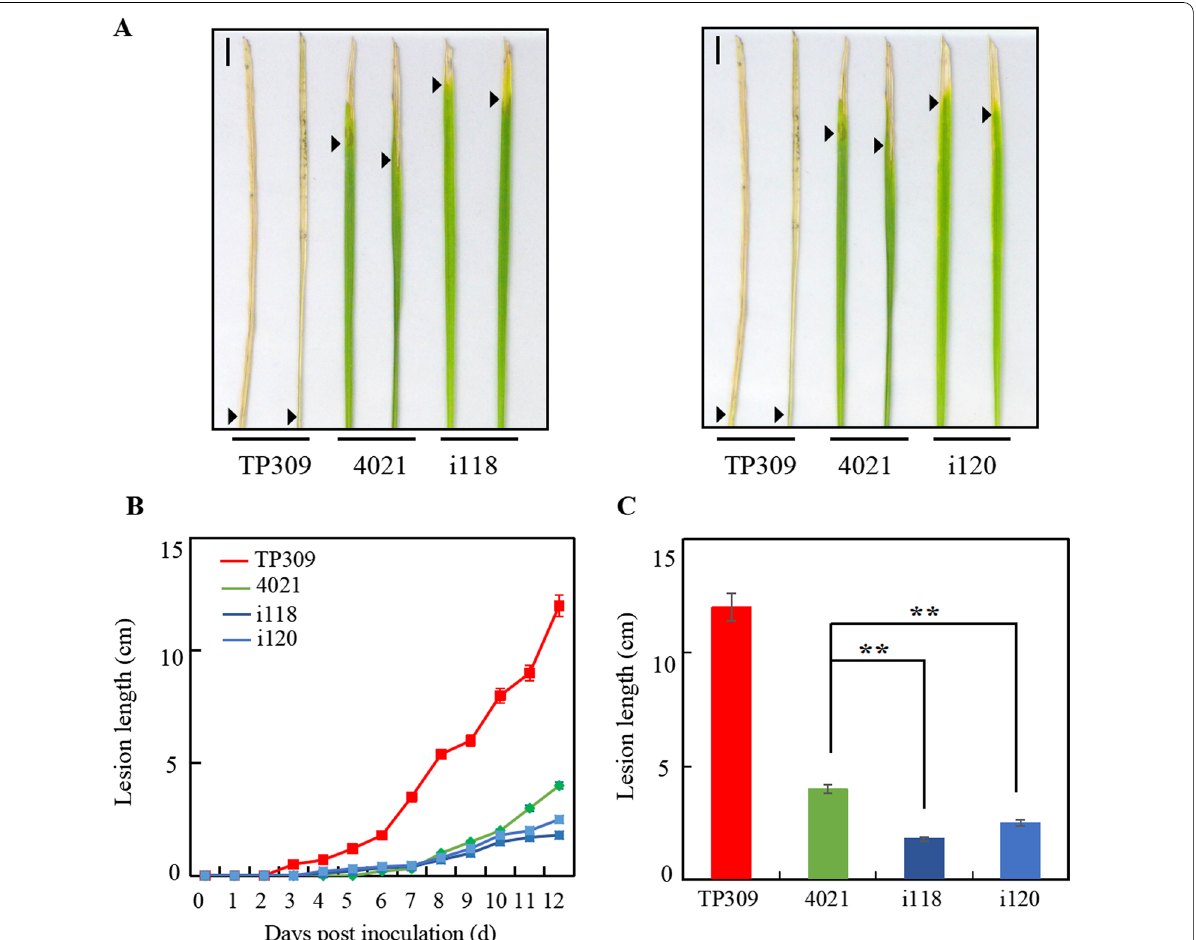
Fig. 6 MPK17 knockdown enhanced Xa21 -mediated resistance. A Disease lesions in inoculated leaves of i118 and i120 and control plants at 12 dpi. B Lesion length at different dpi. C Lesion length at 12 dpi. Arrows indicate the frontline of lesions. **denotes difference at p < 0.01 level. Bar i118 and i120: independent MPK17-RNAi transgenic lines; TP309: Japonica rice; 4021: homozygous TP309 transgenic line harboring the Xa21